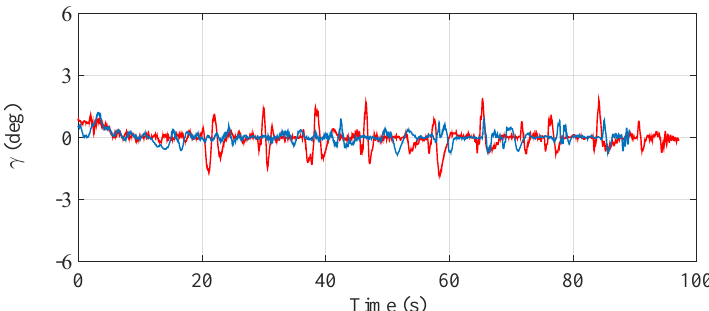
Figure 28. Inclination of the SCMS frame ( γ ) when the optimization is carried out with a α equal to 0.5 ( — ) and when the optimization is not considered ( — ).